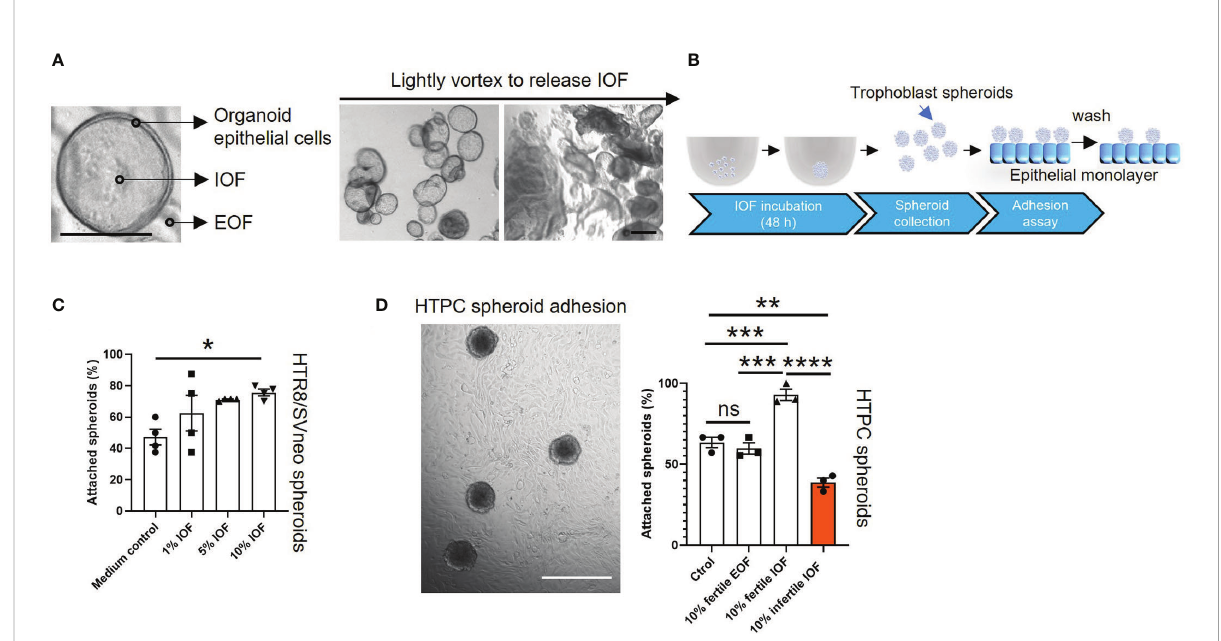
FIGURE 4 Incubation of IOF signi fi cantly changes the adhesive capacity of both HTPC and HTR8/SVneo spheroids. Fertile and infertile organoids were treated with E2+MPA+cAMP and IOF (A) which represent organoid apical secretions were collected to treat trophoblast cells before spheroid adhesion assay. (A) Representative images are presented to demonstrate that after being lightly vortexed, organoids were mildly disrupted to release IOF. The scale bar represents 100 m m. (B) Schematic of IOF treatment before spheroid adhesion assay. (C) HTR8/SVneo cells were treated with three different percentages of IOF 1%, 5% and 10% (v/v) and adhesion on Ishikawa cell monolayers tested. Only incubation with 10% (v/v) fertile IOF signi fi cantly improved HTR8/SVneo spheroid adhesion on Ishikawa monolayer compared to medium control. (D) After optimization, 10% (v/v) fertile or infertile IOF were used to treat HTPC spheroids and their adhesive capacity was determined on fertile organoid derived epithelial monolayer from receptive endometrium. Incubation of fertile or infertile IOF signi fi cantly changed the adhesive capacity of HTPC spheroids compared to medium control and 10% (v/v) fertile EOF control. A representative image of HTPC spheroids attaching to fertile organoid derived epithelial monolayer was shown, scale bar: 400 m m. All data were presented as mean ± SEM (n=3-4 biological